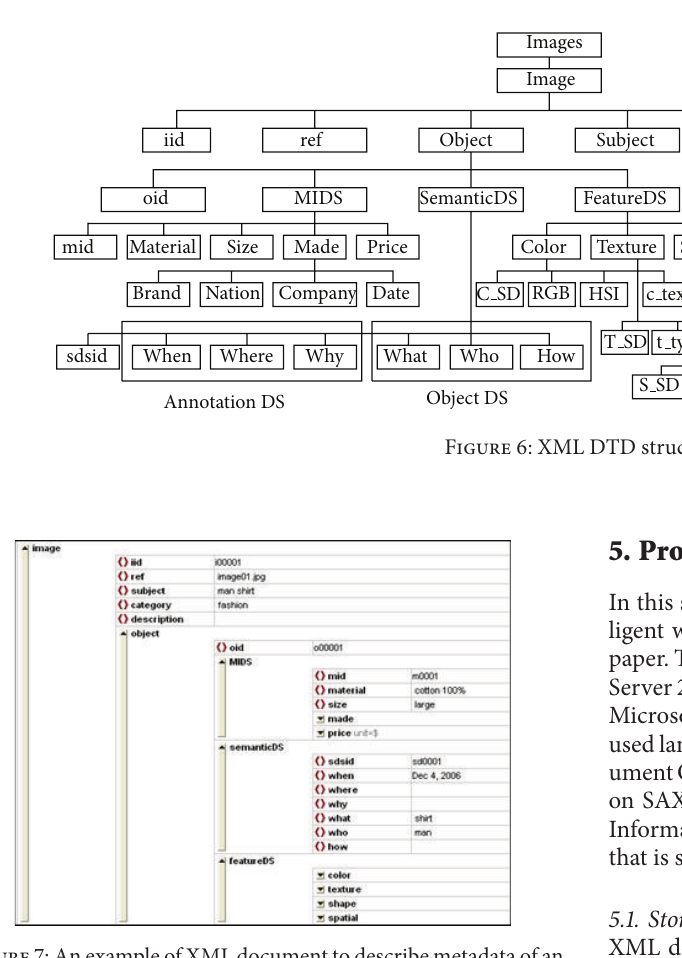
Figure 7: An example of XML document to describe metadata of an e-catalog